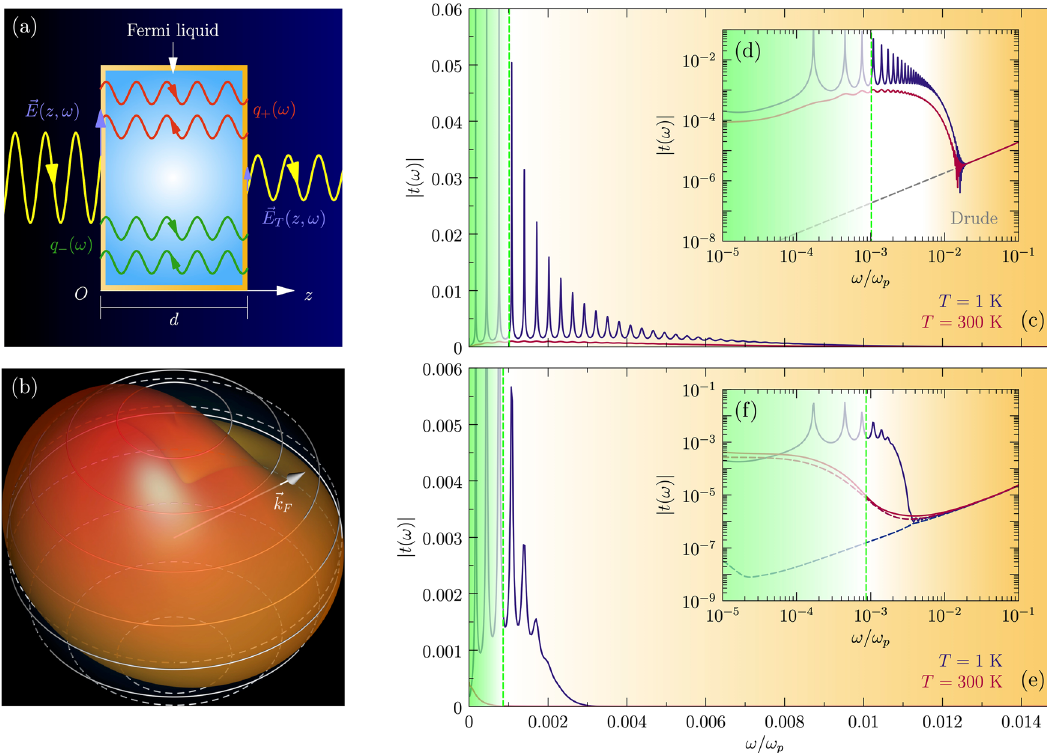
Figure 2. Simulations of optical transmission experiments at normal incidence on a charged Fermi liquid slab. ( a ) Schematics of the transmission experiments on a charged Fermi-liquid slab of thickness d . The incident electric field E ( z , ω) produces the plasmon–polariton and the shear-polariton in the slab, which correspond (ω) and q (ω) for each frequency. Each mode is the sum of two counterpropagating rays to wave vectors q + − from Fabry-Perot internal reflections, which lead to the transmitted field E T ( z , ω) . ( b ) Schematic depiction of the Fermi-surface shear deformation induced by transverse sound. ( c ) Slab transmission modulus t (ω) E T ( z , ω)/ E ( z , ω) , as a function of frequency ω/ω p for a Fermi liquid in the Galilean continuum at | | = | | 10 c /ω 300 K (red line) and T 0.1 µ m 1 K (blue line). We assume a slab thickness d temperatures T p ( ∼ = = = 3 ), Landau parameters F S 10 23 cm 1 and F S 20 , and the slip length corresponding to for a density n − 0 = 1 = = 3.8 ( cf. Methods). The shear mode submerges into the continuum specular interface scattering with hh ′ k 2 F = below the dashed green line. ( d ) Same data as in panel c on logarithmic scale. The gray dashed line shows t (ω) the result for a standard Ohmic conductor. ( e ) Slab transmission modulus for a charged Fermi liquid | | 0.5 , and acoustic phonons with Debye including momentum relaxation due to Umklapp scattering with α U = 0.1 . All other parameters are as in temperature (cid:31) ω D / k B 500 K and electron-phonon coupling constant (cid:31) = = panels ( c, d ). ( f ) Same data as in panel ( e ) on logarithmic scale. The gray dashed line is the result for an Ohmic conductor. Panels ( a ) and ( b ) were generated with Asymptote version 2.45, url: https:// asymp tote. sourc eforge.